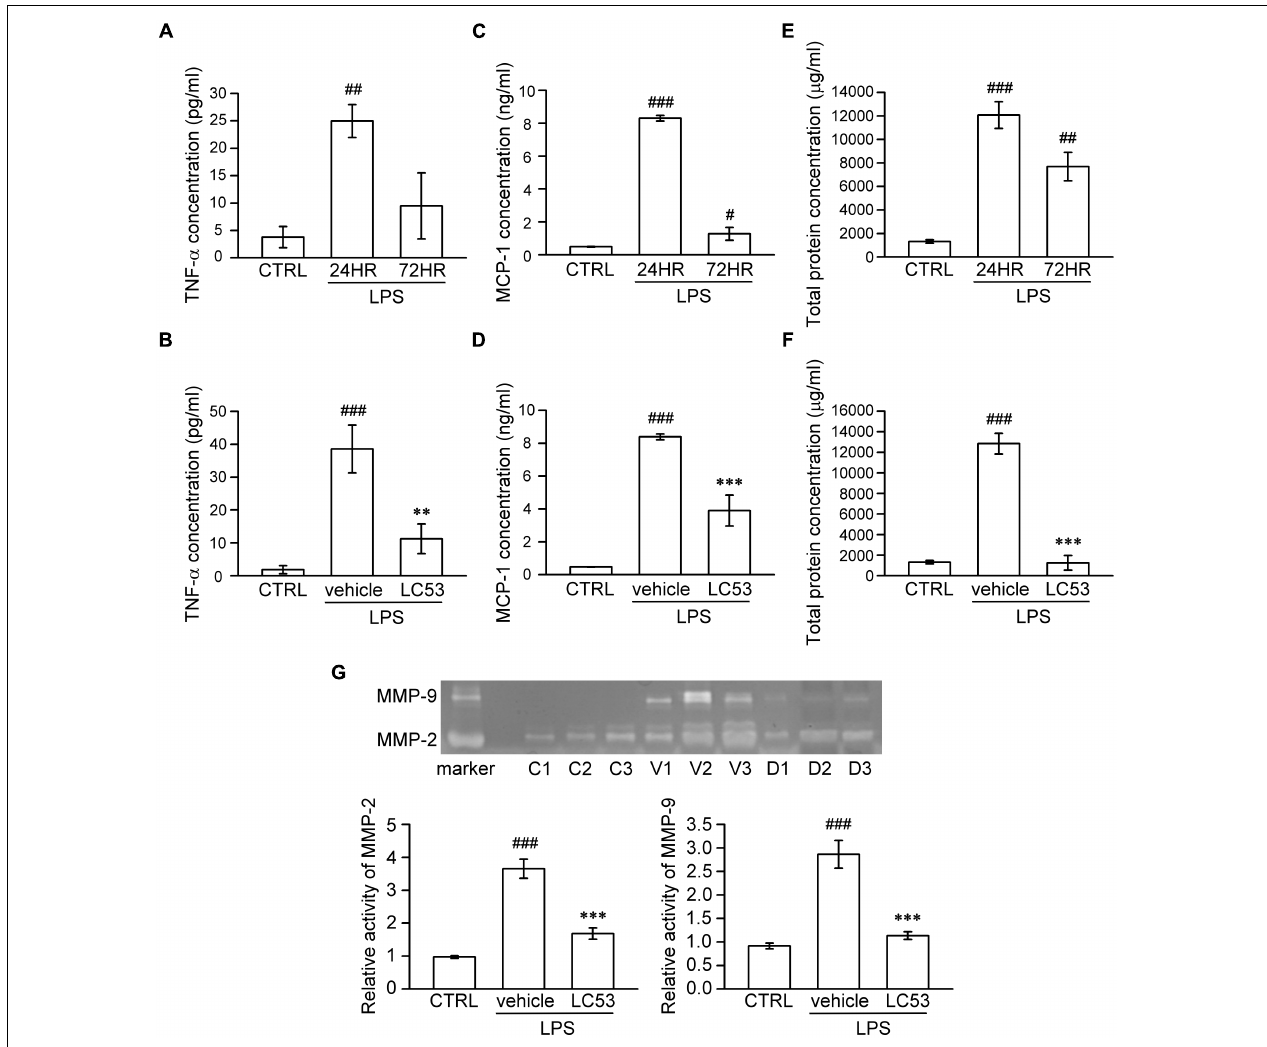
FIGURE 2 | LC53 decreased the levels of TNF- α and MCP-1, protein exudation, and activation of MMP-2 and MMP-9 in rat aqueous humor. Fresh aqueous humor was obtained by anterior chamber puncture with a 30-gauge needle from euthanized rat. (A,C,E) Quantification of the time courses of MCP-1, TNF- α , and protein amount of aqueous humor, indicating that anterior ocular inflammation peaked at 24 h after LPS (1 mg/kg)-injection in aqueous humor. (B,D,F) Quantification of the average amount of TNF- α , MCP-1, and protein amount from control and EIU rat 24 h after LPS-injection in the presence or absence of LC53 (20 mg/kg). (G) MMP-9 gelatinolytic activity in aqueous humor was evaluated by zymography. The referenced markers were from medium of HT-1080 cell line, which constitutively secreted MMP-2 and MMP-9. The quantification values were presented as the mean ± SEM of results from 4 to 6 animals. Representative bands from 3 independent experiments were shown for each group: the control groups (C1, C2, C3), vehicle-treated EIU groups (V1, V2, V3), and LC53-treated EIU groups (D1, D2, D3). CTRL: control. # p < 0.05, ## p < 0.01, ### p < 0.001 compared with the control group treated with normal saline; ∗∗ p < 0.01, ∗∗∗ p < 0.001 compared with the EIU group treated with